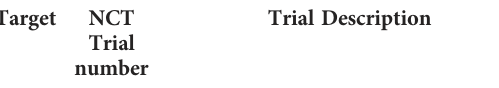
TABLE 1 Clinical trials testing CAR T cell therapy in paediatric brain tumours.